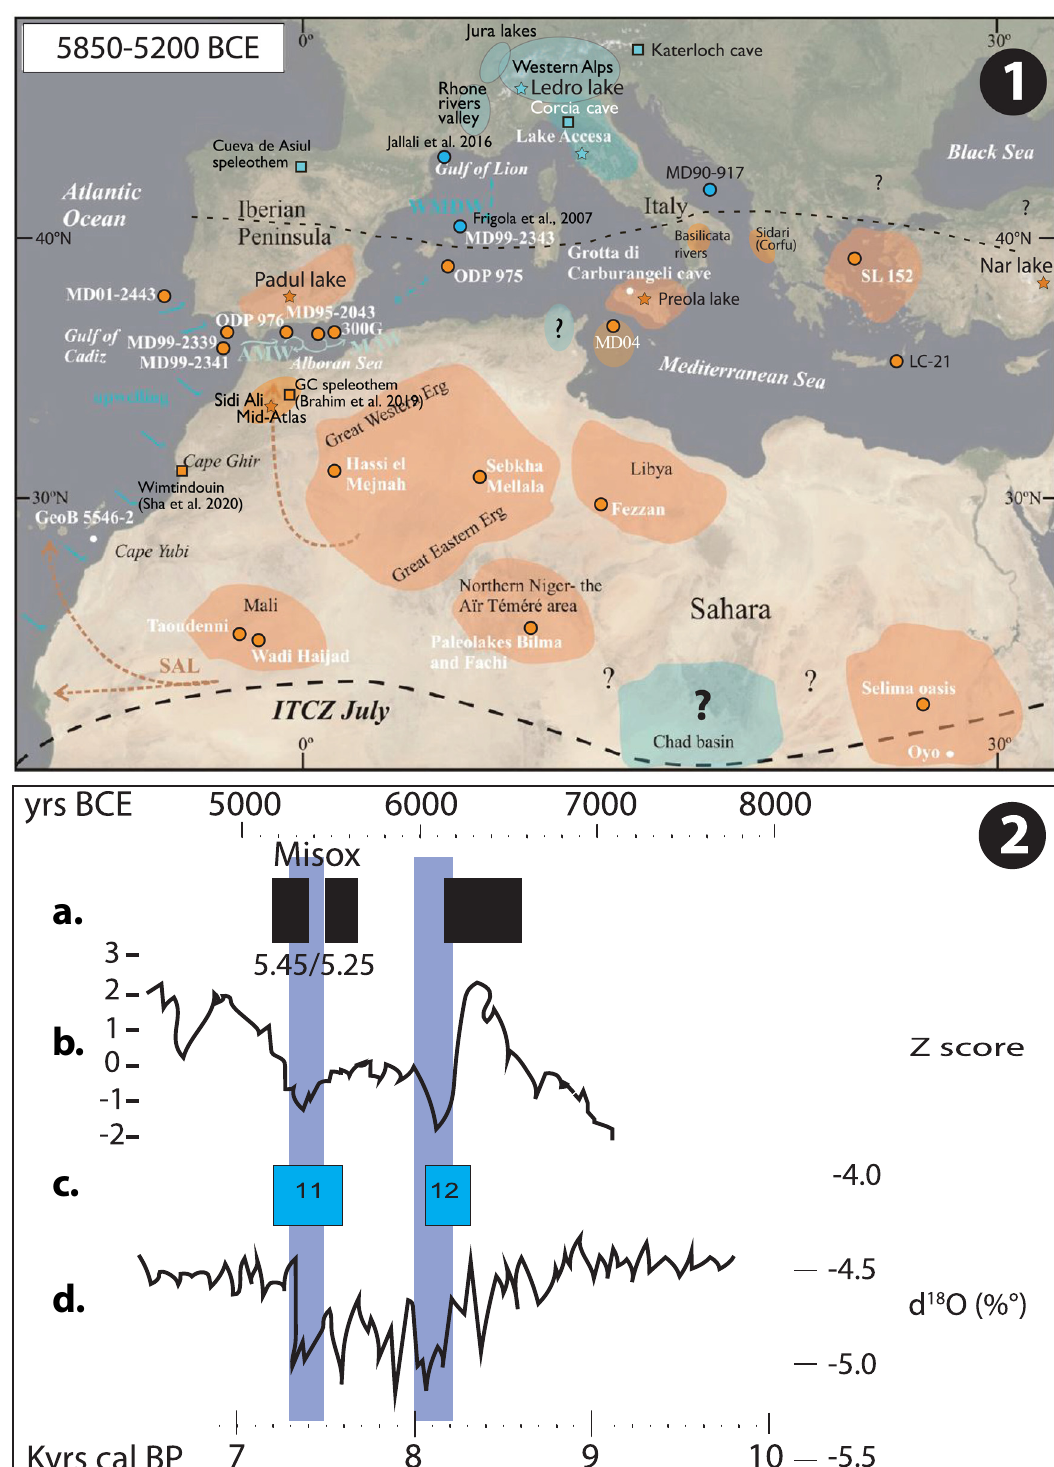
Figure 3: ( 1 ) Map with the di ff erent paleoenvironmental records documenting paleohydrological and paleoenvironmental variations in the western Mediterranean basin and North Africa. Light blue/orange areas show wet/dry conditions, respectively, obtained in each paleorecord at this time interval ( 5850 – 5200 BCE; modi fi ed after Sánchez et al., 2012 ) . ( 2 ) Synthesis of robust climatic - environmental data from the Austrian to French Alps and Apennine mountains between 8000 and 5000 BCE, ( a ) Glacial transgression in Alps mountains ( Holzhauser, Magny, & Zumbuühl, 2005 ) , ( b ) Central Alpine subfossile trees at the treeline ( Nicolussi et al., 2009 ) , ( c ) phases 11 and 12 of Lake transgressions in north Alps and Jura ( Magny, 2004 ) , and ( d ) Monte Corchia cave speleothem - CC26 illustring a long discontinued wet period by a d 18 O decrease ( Zanchetta et al., 2007 ) . The vertical blue bands illustrate the coolest and wettest periods in the area of the western Alpine